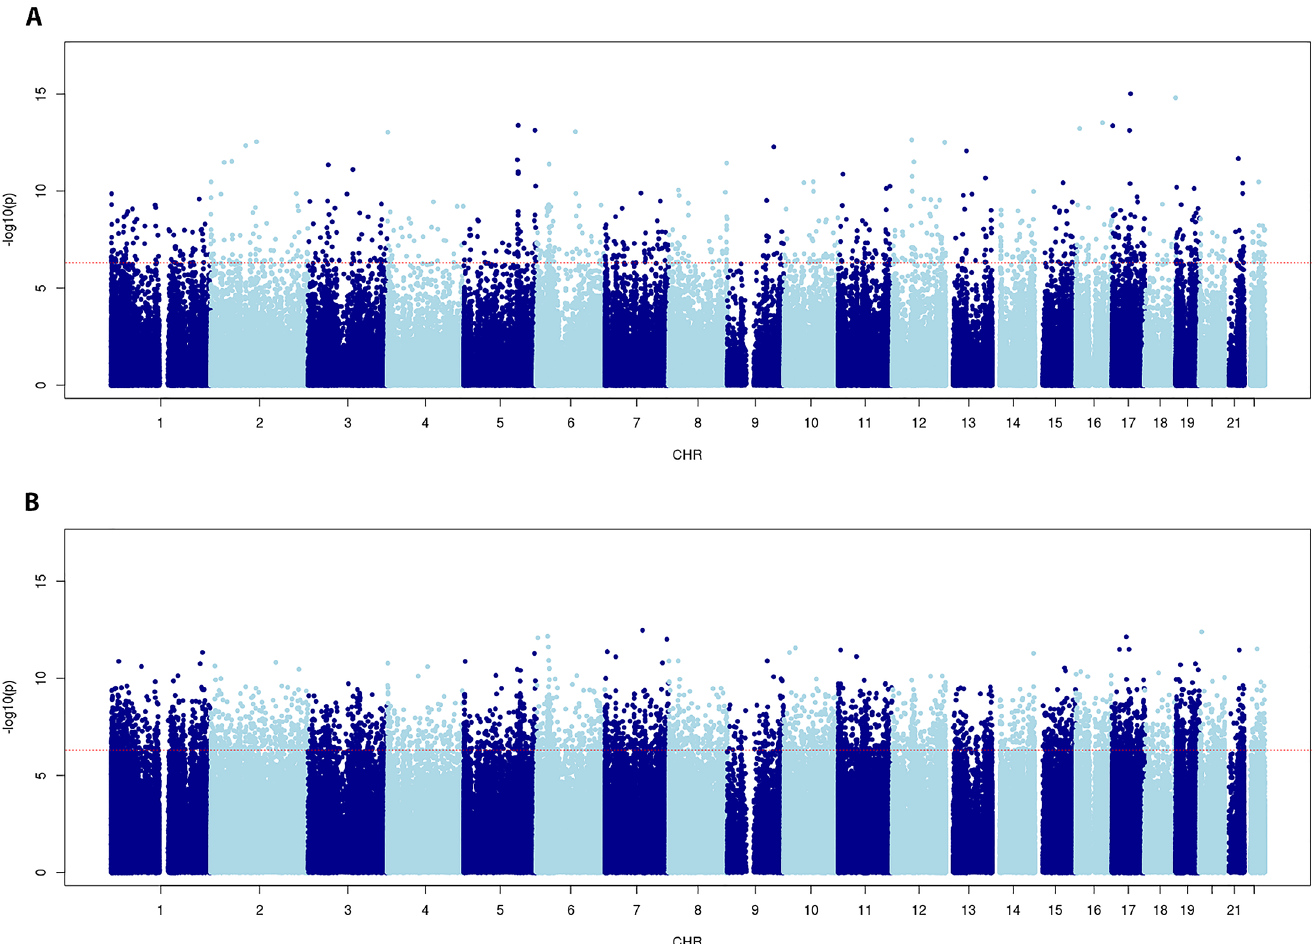
Fig 2. Manhattan plots. (A) Manhattan plot DMP association analysis (probes associated with SNP, MAF > 0,05, and probes located on X and Y chromosomes were excluded from analysis), corrected for gender but not for blood cell distribution. X-axis represents ranked chromosomes, Y-axis represents–log10 (P-value). Redline indicates significance level (Bonferroni; P < 5 10 −7 ). (B) Manhattan plot DMP association analysis (probes associated with SNP, MAF > 0,05, and probes located on X and Y chromosomes were excluded from analysis), corrected for gender and blood cell distribution. X-axis represents ranked chromosomes, Y-axis represents–log10 (P-value). Red line indicates significance level (Bonferroni; P < 5 10 −7 ).